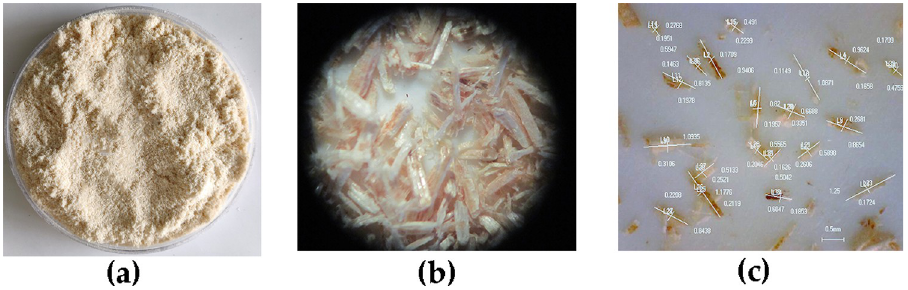
Fig 4. The measurement process of wood fiber morphology, (a) Poplar fiber sample, (b) Micromorphology of WFs under 80x eyepiece, (c) Measurement of aspect ratio under 40x HD digital microscope.